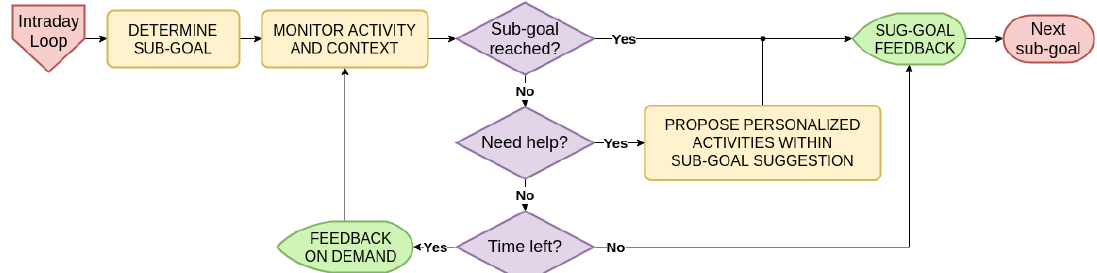
Figure 5. Adaptive System for Physical Activity: Support Phase-Intraday Sub-Goal Time Scale. An ideal sub-goal (3000 steps halfway through the day for example) is determined according to the objective of the day (e.g., 6000 steps). A control loop is run hourly to monitor user physical activity level and to evaluate if she is making good progress toward the sub-goal. If self-management (left loop) is not sufficient, the system can intervene to propose the user a personalized physical activity adapted to the current context (right inner loop), or move to the next sub-goal in case of failure (right outer